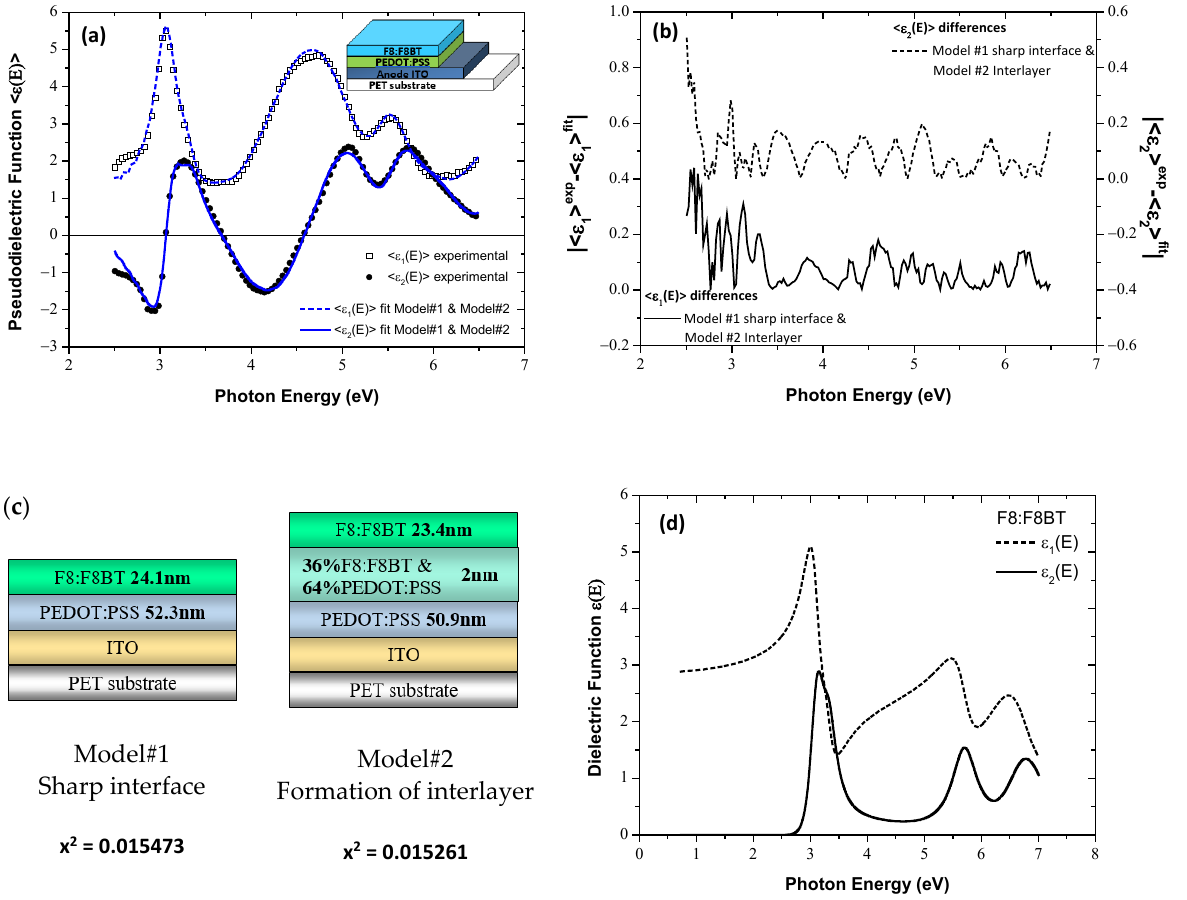
Figure 4. ( a ) The measured SE spectra of the F8:F8BT film, grown on PET/ITO/PEDOT:PSS (symbols) and the corresponding fitted ones (lines). Inset shows the geometrical structure of the sample. ( b ) The calculated deviations between the experimental and fitted SE spectra. ( c ) The schematical representation of the models applied in SE fitting analysis. ( d ) The dielectric function ε(E) of the slot-die F8:F8BT, calculated using the best-fit parameters derived by SE analysis.